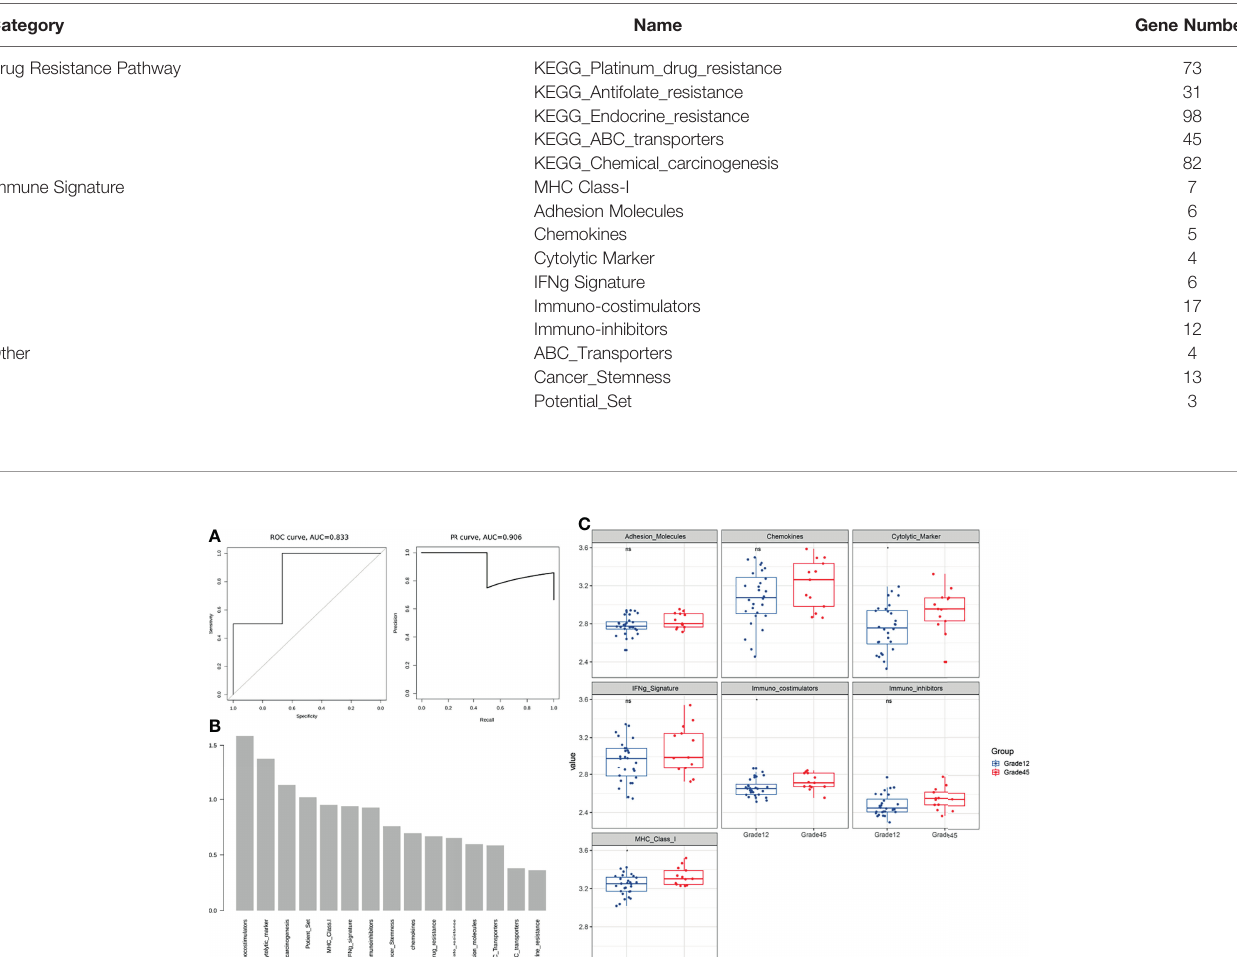
TABLE 2 | Features used in random